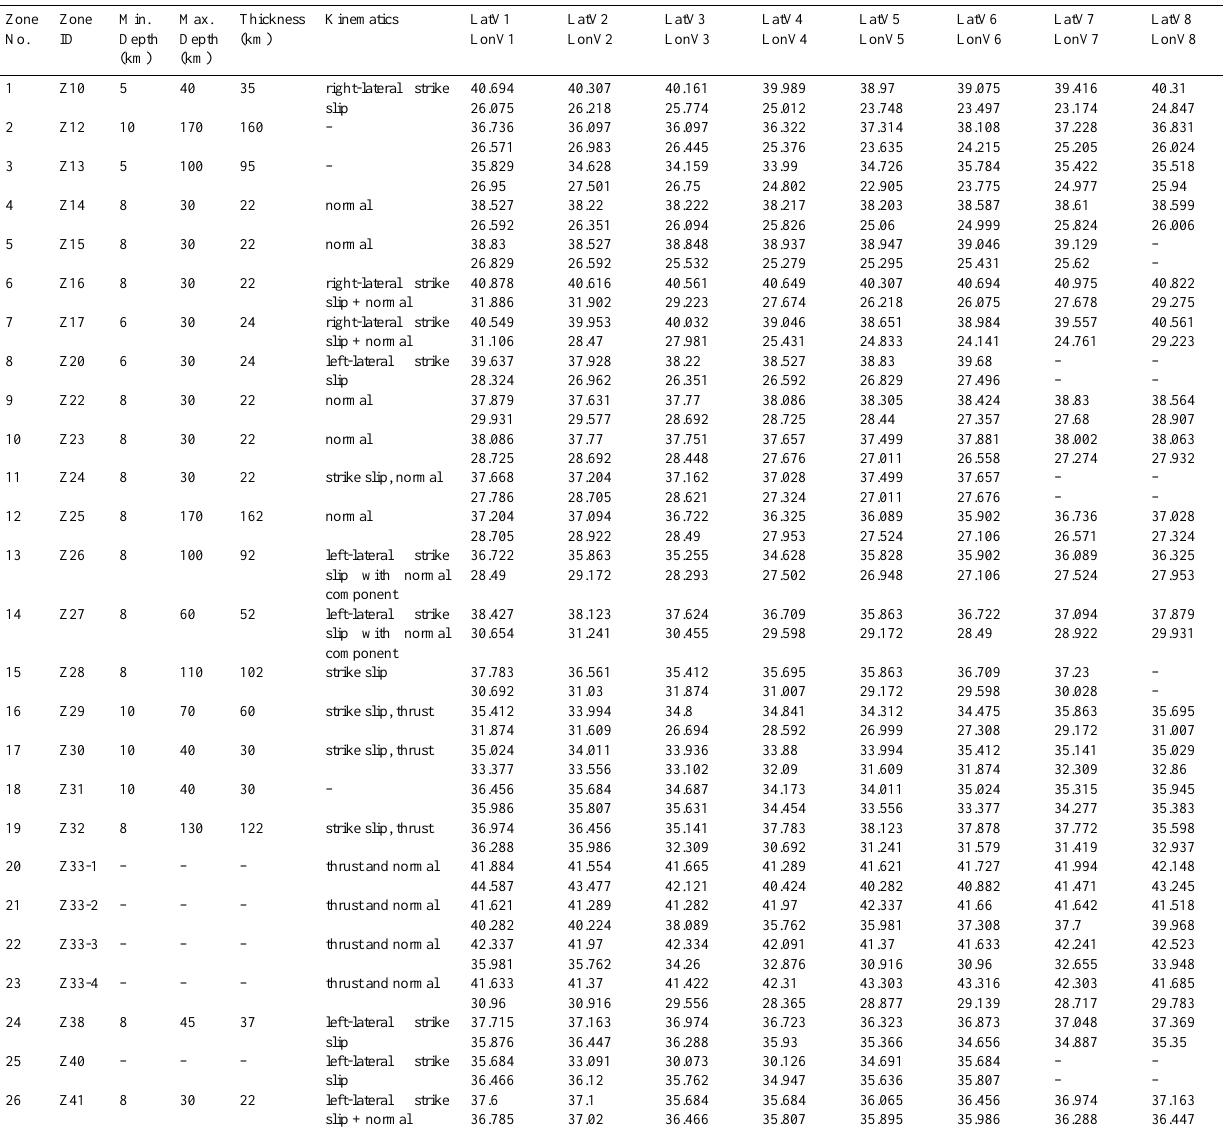
Table 1. Tsunamigenic seismic zones in and around Turkey: a summary table representing kinematic parameters and geographical coordi- nates for each zone.